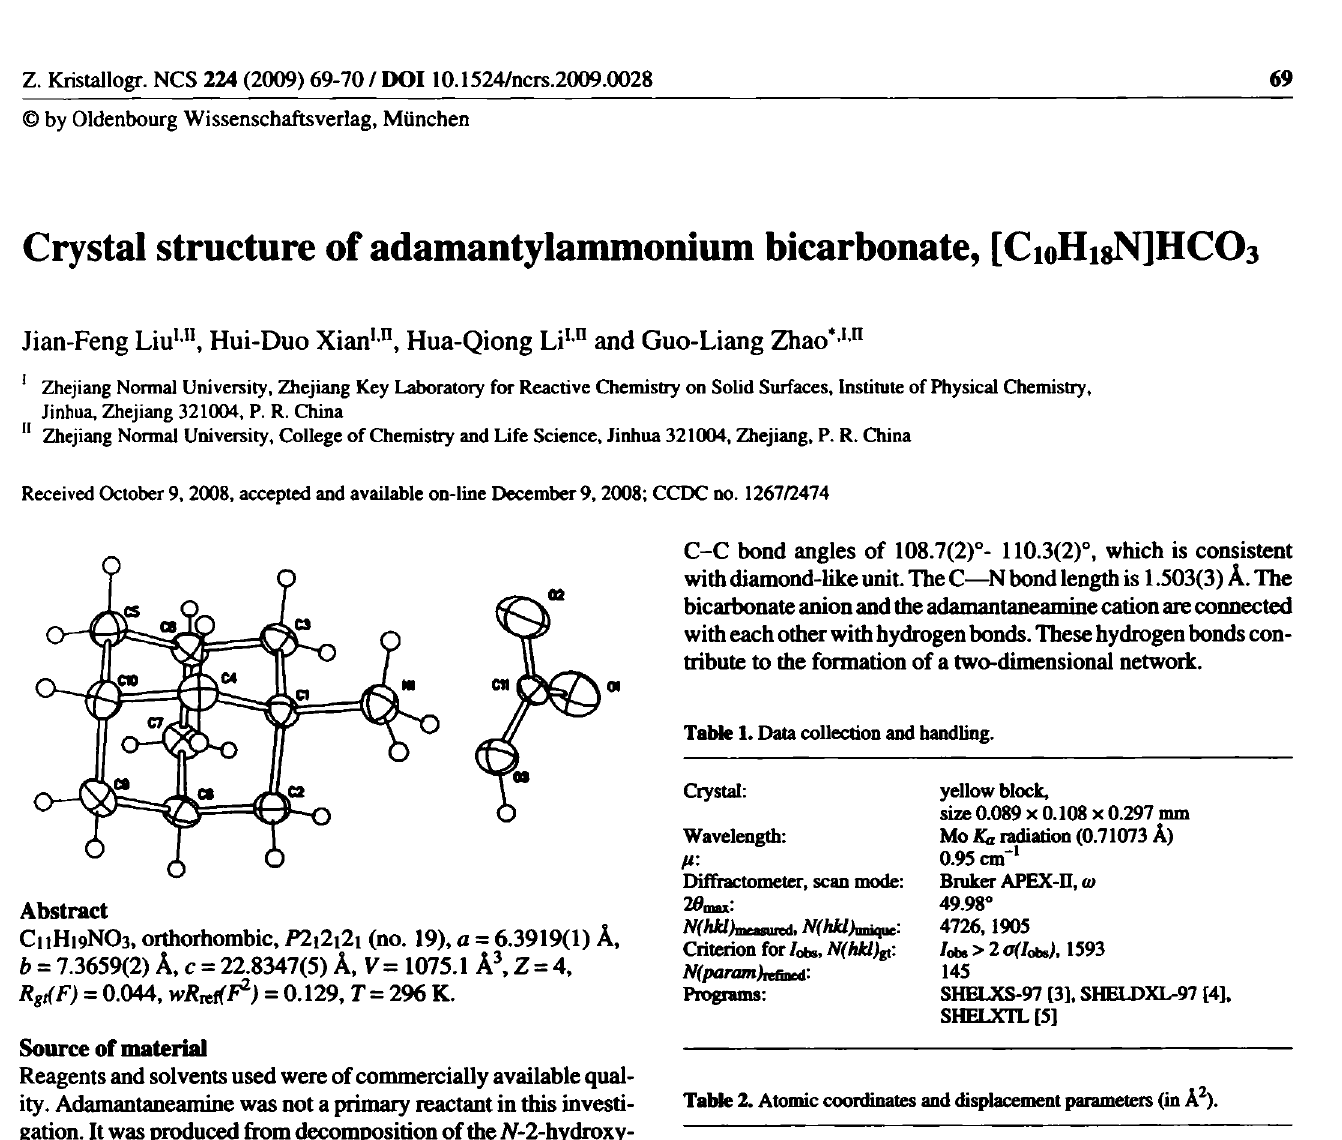
Table 2. Atomic coordinates and displacement parameters (in À 2